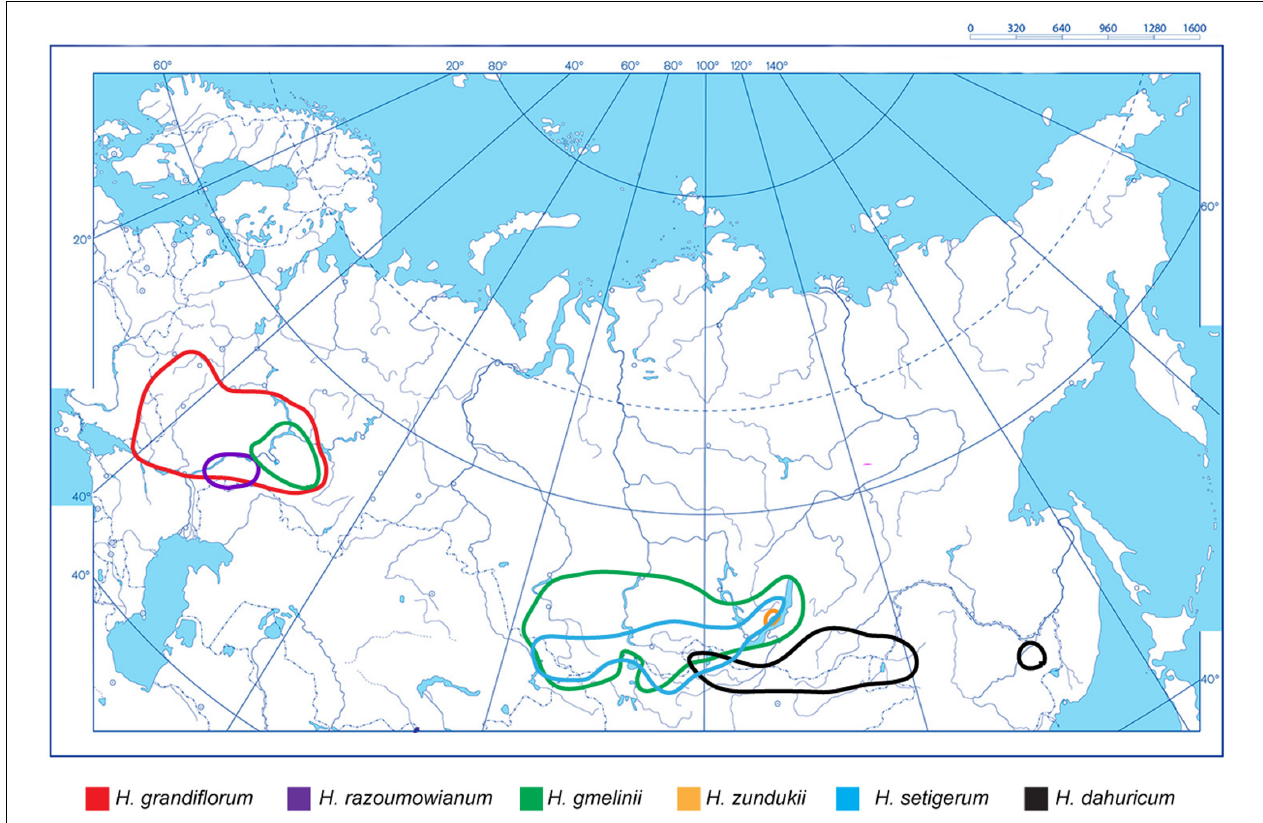
FIGURE 1 | An integrated schematic map showing distribution of H. grandiflorum , H. razoumovianum , H. dahuricum , H. zundukii , H. gmelinii , and H. setigerum within the northern, central, and eastern parts of Eurasia. The species names and correspondent colors of the lines indicating the boundaries of the species occurrence are specified under the